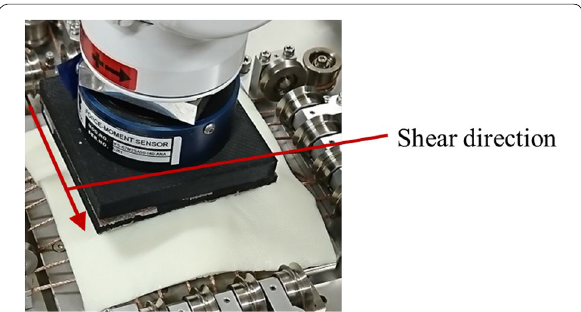
Fig. 11 Transverse modulus evaluation of the reproduced shape